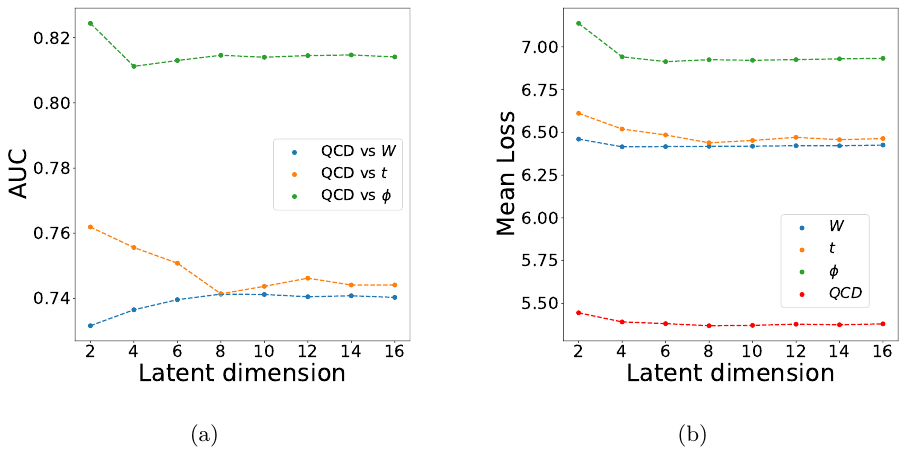
Figure 4 . The AUC and mean loss for the three signal classes as a function of latent dimension from 2 to 12 for the given architecture.